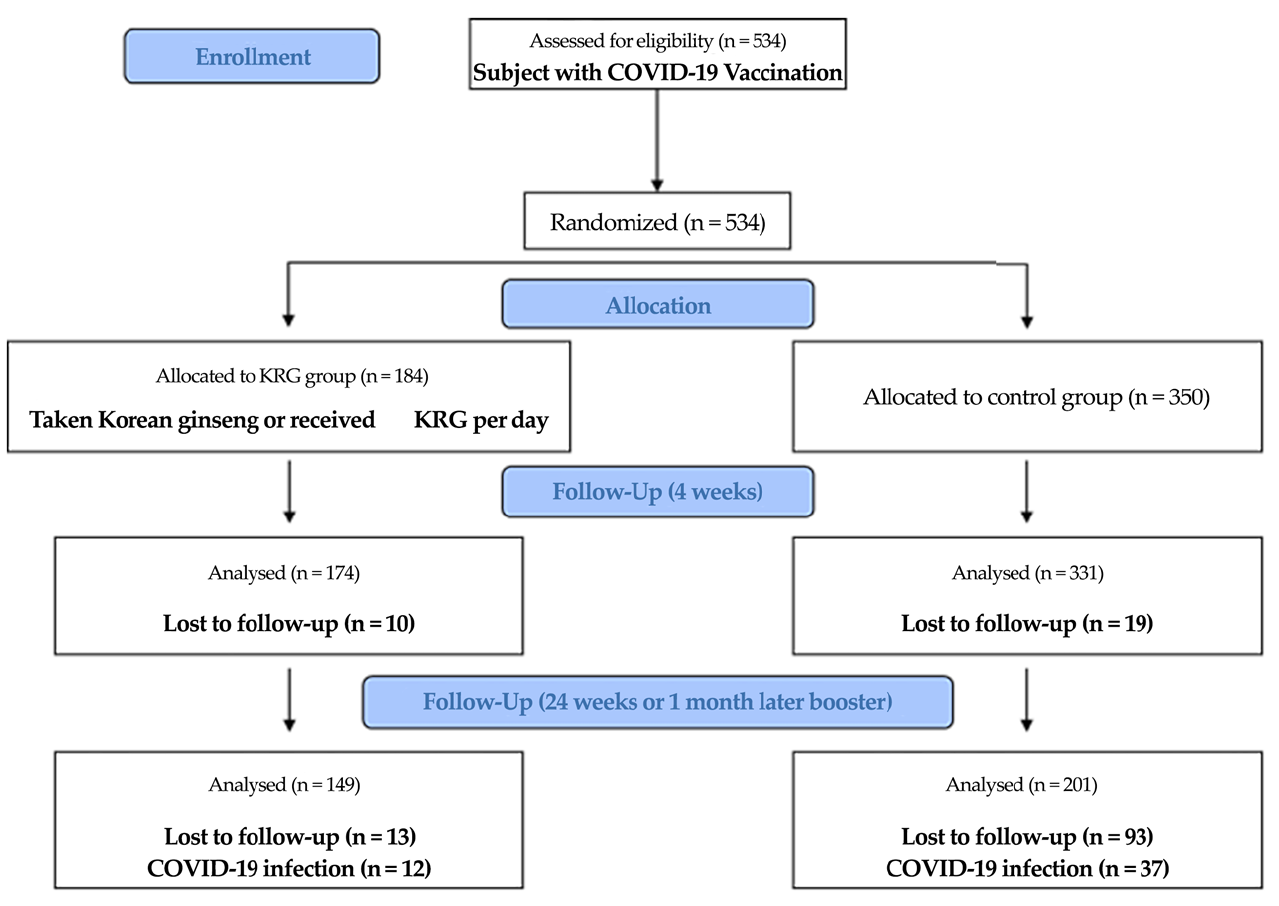
Figure 1. Flow chart for participant selection.